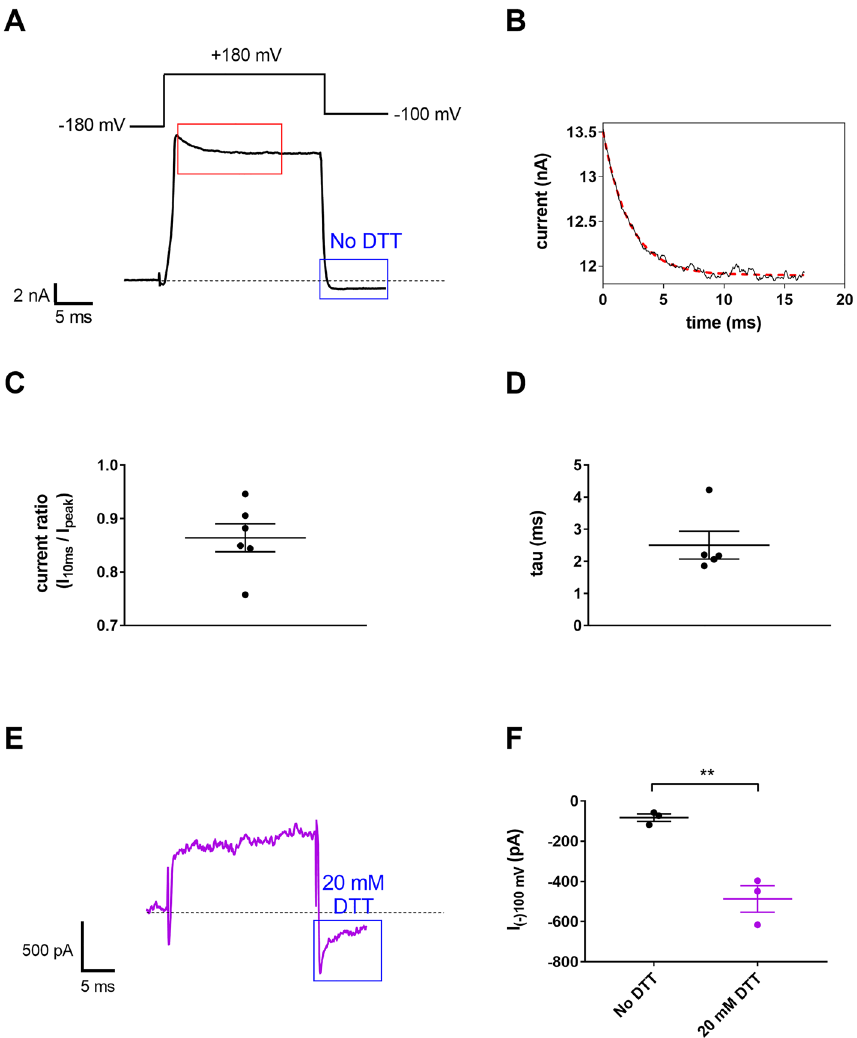
Figure 4. K Ca 1.1 β3 subunit is functionally expressed in U-87 MG cells ( A ) Representative current trace recorded in a U-87 MG cell using the voltage protocol shown on the top and 10 µM free Ca 2+ in the pipette filling solution. The red rectangle highlights current inactivation whereas the blue rectangle marks the current at − 100 mV in the absence of DTT. ( B ) Inactivation of the current (red rectangle in panel A) at an increased resolution. Continuous black line is the measured current, dashed red line is the fitted trace using a single exponential decay model. ( C ) The current ratio I 10ms /I peak denotes the ratio of the current at 10 ms following the start of the depolarization over the peak current. ( D ) Scatter plot of the inactivation time constants (tau) determined from fitting single-exponential decaying function to the currents. ( E ) Instantaneous (tail) current (blue rectangle) in a U-87 MG cell treated with 20 mM DTT for 20 min. The current was recorded using the pulse protocol in panel A. ( F ) Peak currents at − 100 mV for control U-87 MG cells in the absence of DTT (No DTT, black dots) and following 20 min application of 20 mM DTT (20 mM DTT, purple dots). Throughout the figure dots represent individual measurements horizontal line and error bars indicate mean ± SEM. * p <